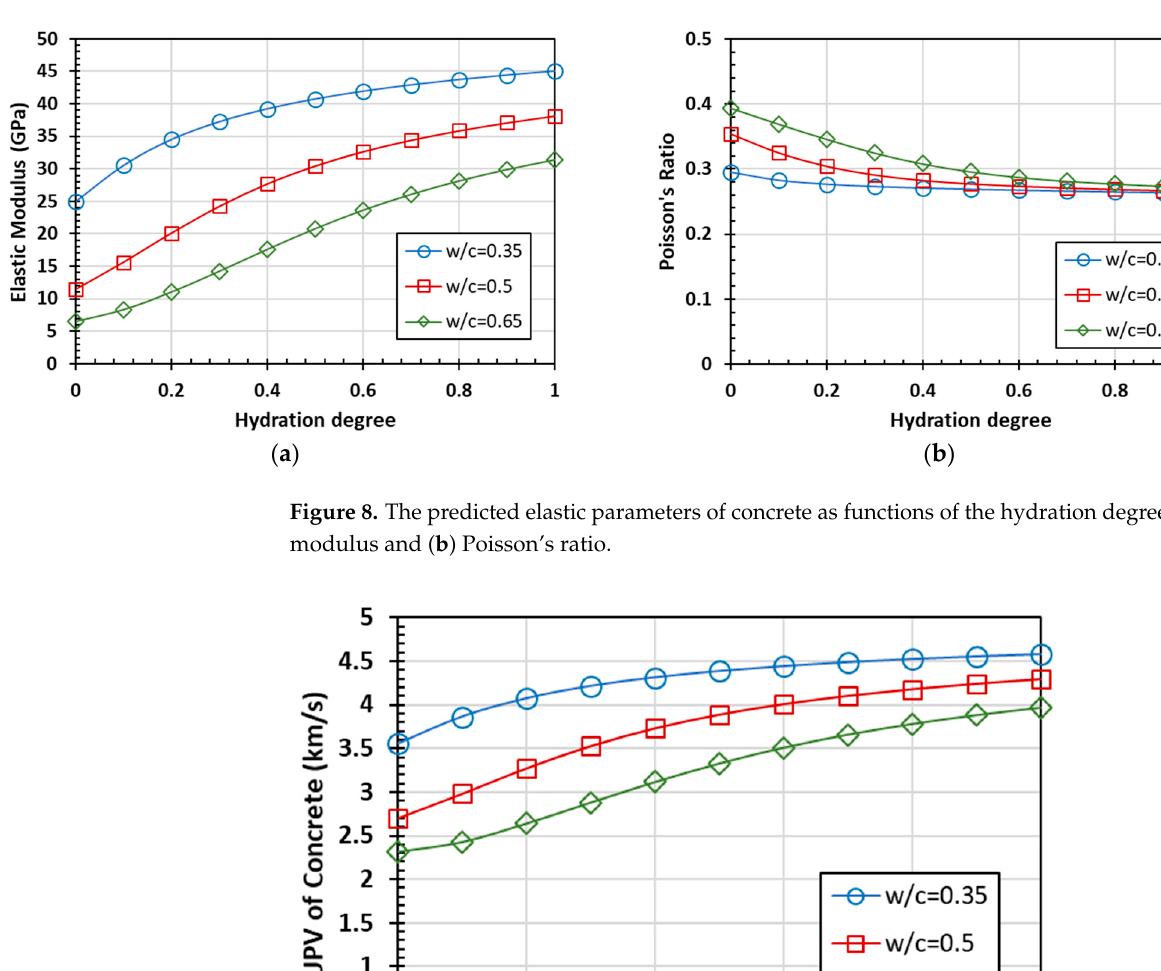
Figure 9. The ultrasonic pulse velocity prediction of concrete.